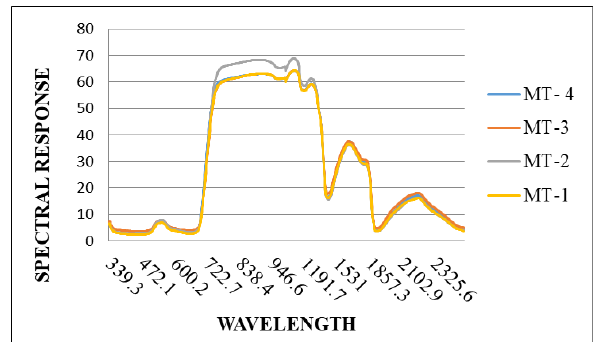
Figure 7.Spectral response curve for four different mango trees inside campus